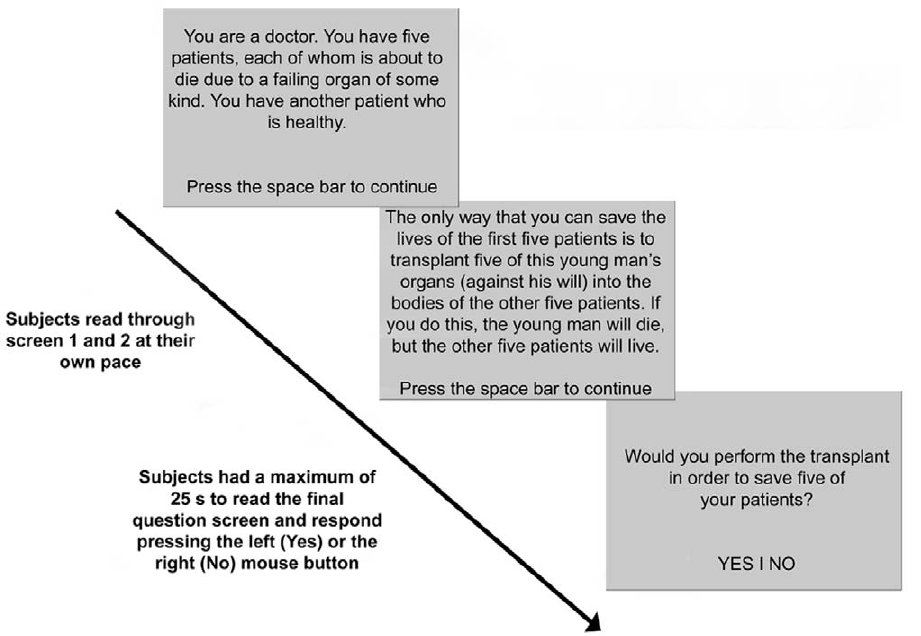
Figure 2. Task sequence for personal moral dilemmas. The sequence was the same for non-moral and impersonal moral dilemmas. Each dilemma was presented in a series of three screens of text. The first two screens each displayed a paragraph describing the context and details of the dilemma. The third screen posed a question about a hypothetical action related to the scenario (‘‘Would you … in order to …?’’). Participants were allowed to read through screens 1 and 2 at their own pace, pressing the space-bar to advance to the next screen. In the third screen, they were allowed no more than 25 s to read the final question screen and respond by pressing the left (yes) or the right (no) button on the mouse. In this situation, because the subject decides to sacrifice one person in order to save five persons, ‘‘Yes’’ is the utilitarian response that allows the maximum advantage (five alive) and the minimum disadvantage (one dead). The 60 dilemmas were randomly divided into two 30-item alternate versions of the test. These two versions were administered in a counterbalanced order, half of the subjects receiving version 1 at baseline and version 2 after tDCS, and half receiving the opposite order.